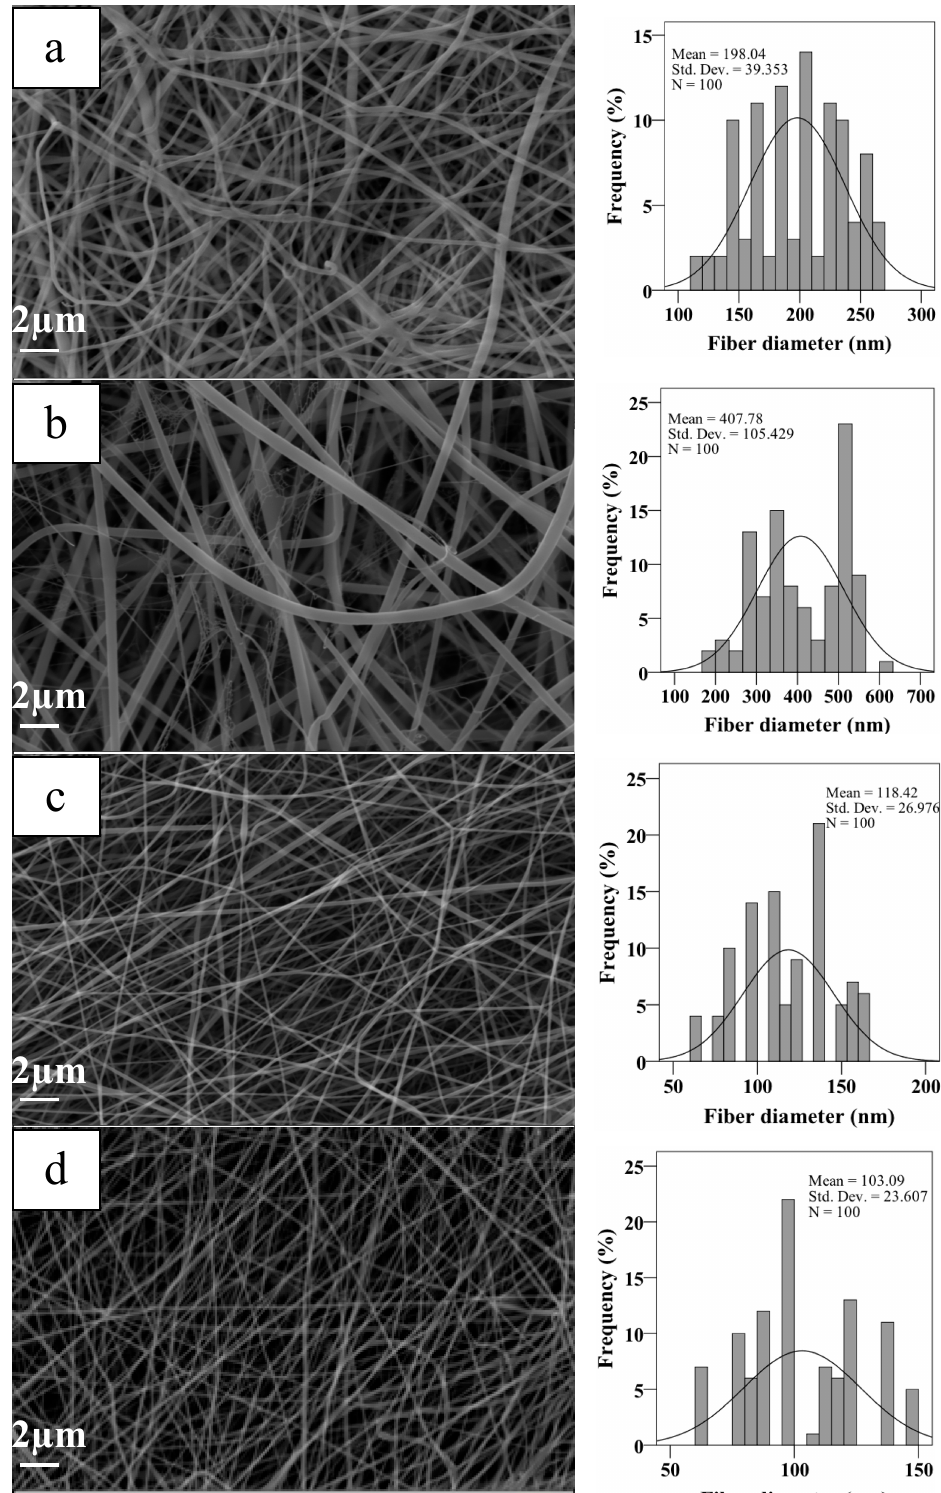
Figure 2. SEM images and fiber diameter distributions of scaffolds ( a ) PCL/Gel, ( b ) PCL/Gel/HA0.5, ( c ) PCL/Gelxy, and ( d ) PCL/Gel/HAxy.